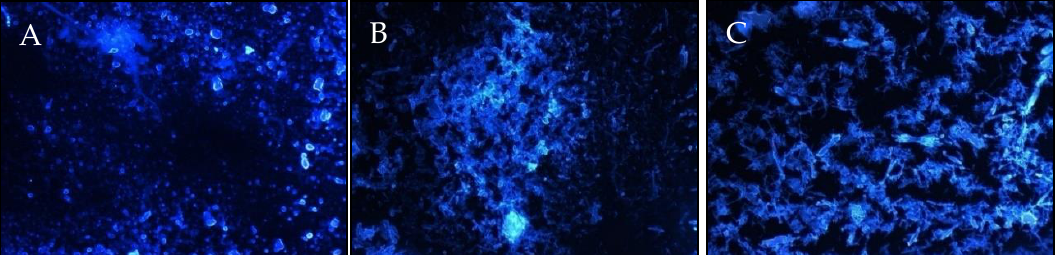
Figure 14. Visualization of polysaccharides containing β -glycosidic bonds (using Fluorescence Brightener 28 dye) in the ethanol precipitated EPS (EP) from cultures of F. culmorum strains: ( A ) DEMFc2, ( B ) DEMFc5, ( C ) DEMFc37.